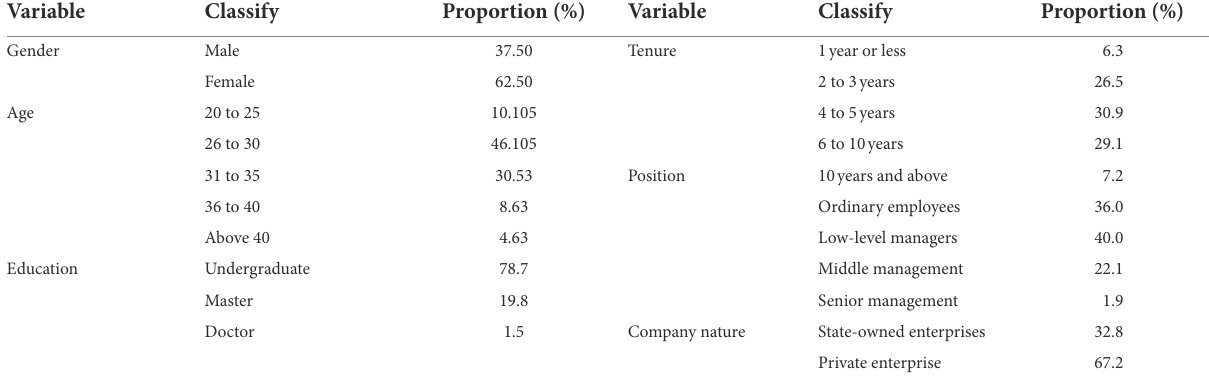
TABLE 1 Basic sample information.